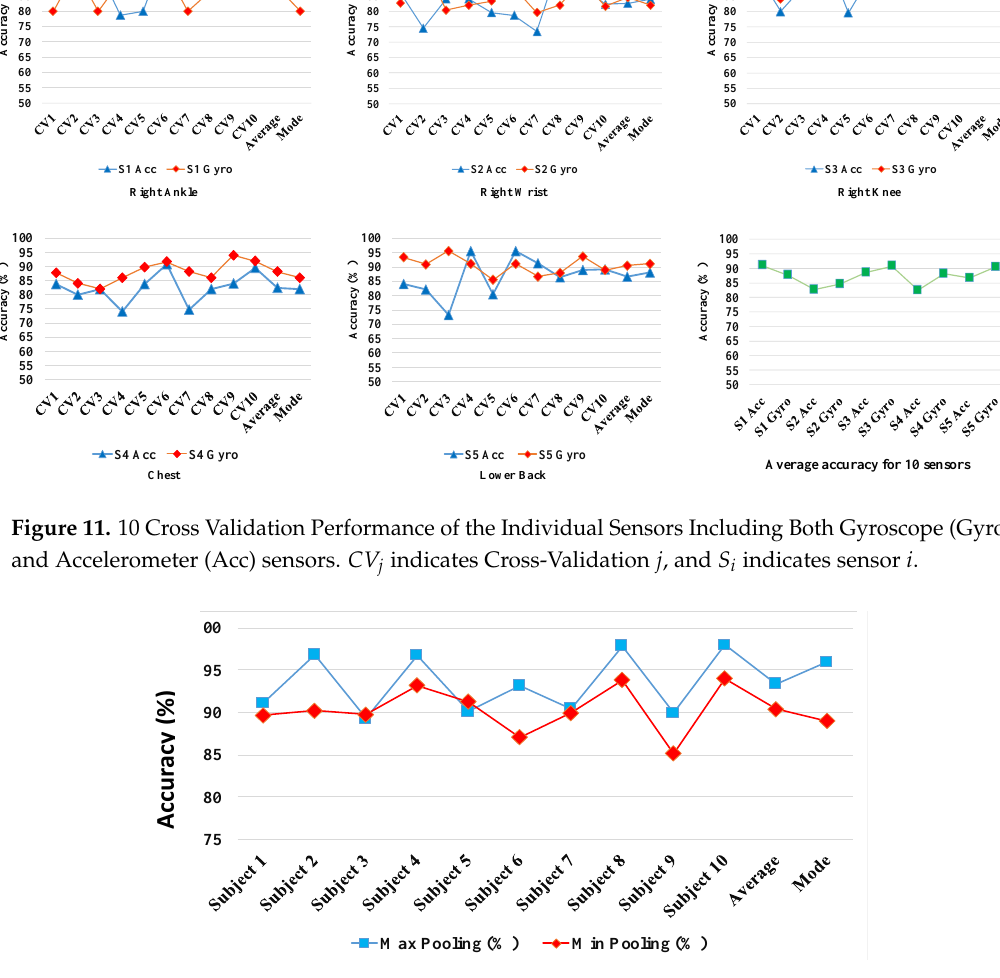
Figure 12. Multi-sensor early fusion performance using min and max